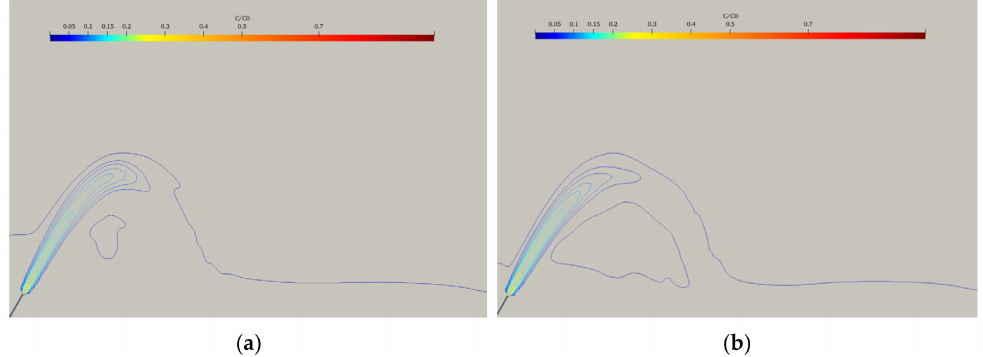
Figure 10. Concentration contours at the central plane for ( a ) case C2 and ( b ) case